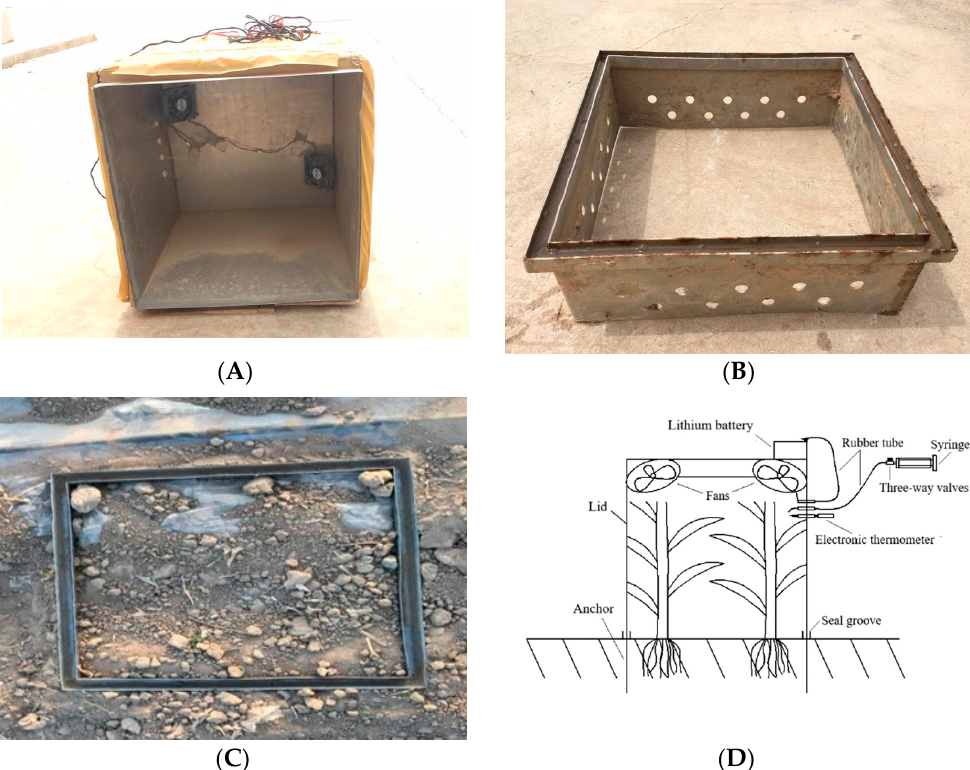
Figure 3. Structure of the static closed chamber showing ( A ) the lid, ( B ) the anchor, ( C ) the top view of the anchor embedded in the plot, and ( D ) the side view of the static closed chamber working.